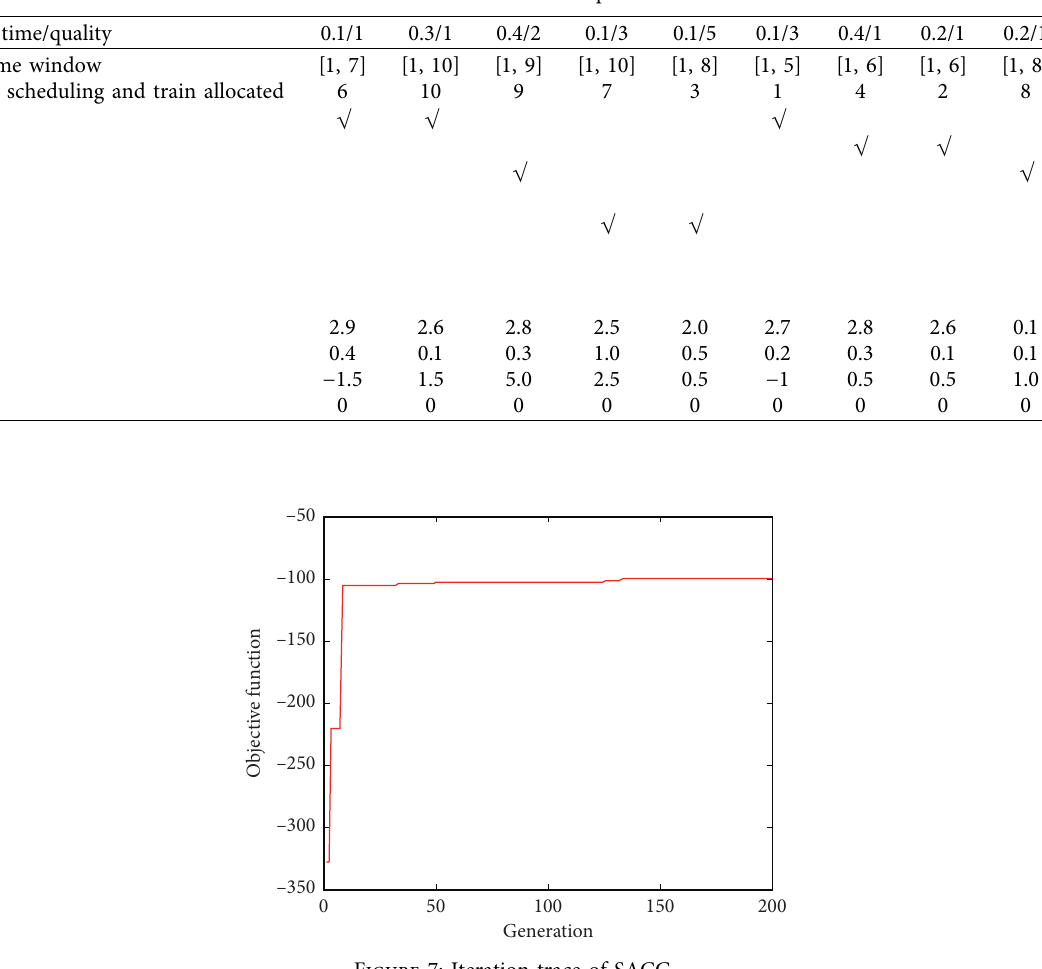
Table 2: Solution for the sample network.